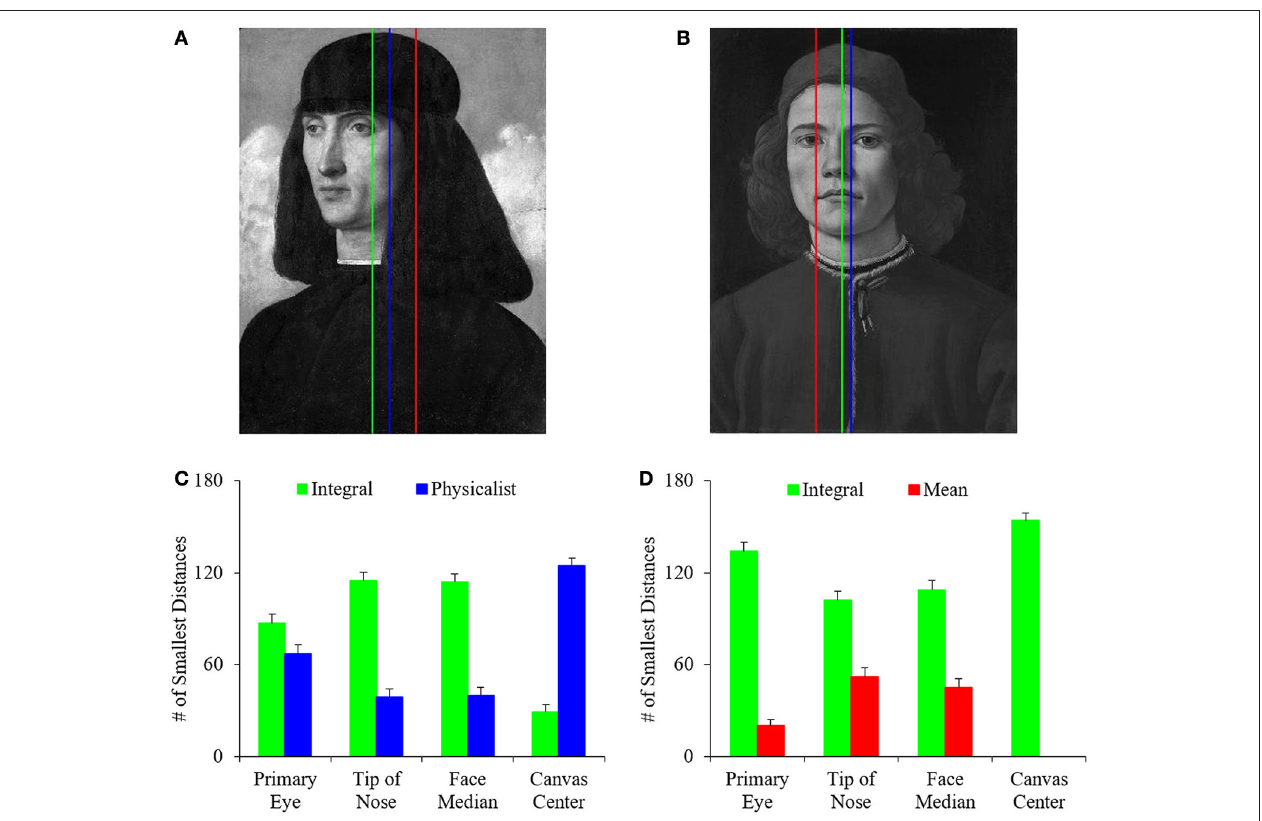
FIGURE 2 | Comparison of the different definitions of balance. (A,B) Examples of where each of the best balance lines fall (Equation 7) for Portrait of a Man by Giovanni Bellini (Musée du Louver, Paris, France; reproduced by permission of © Reunion des Musees Nationaux, Paris, France) and Portrait of a Young Man by Sandro Botticelli (reprinted here with permission by the © National Gallery, London, Great Britain) respectively. These are Integral (green), Physicalist (blue), and Mean (red) balance lines. The integral balance line is closest to the center of the face in these two examples. (C) Number of times that Integral or Physicalist balance line was closest to the indicated feature of interest in 153 paintings. (D) Number of times that Integral or Mean balance line was closest to the indicated feature of interest. The Integral Balance line was significantly closer to important facial features, whereas the physicalist line was significantly closer to the center of the